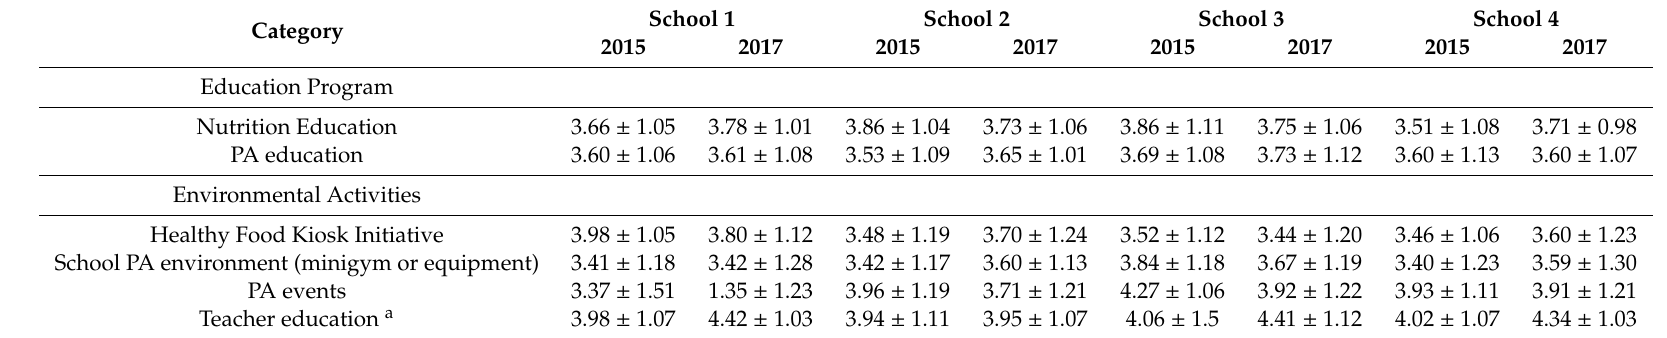
Table 5. Mean Satisfaction Scores by Students and Teachers in Relation to HPS Obesity Prevention Program